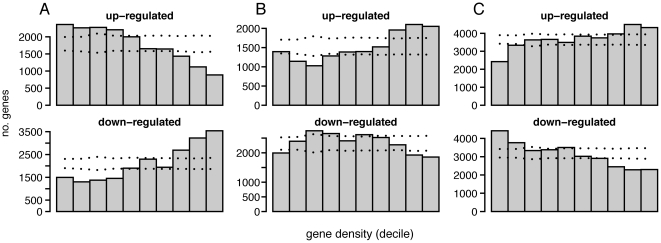
Density-dependent gene expression changes in diseased samples.Barchart showing the number of genes up-regulated (gray bar) or down-regulated (white bar) in diseased tissues compared to control (p<0.05). Genes were divided into 10 groups of equal size, according to the gene density. Dotted lines indicate 95% interval calculated from genome-wide permutation, shuffling regional gene density associated with each gene. (A) Entorhinal cortex [18] (B) Hippocampus [18] (C) Skin lesions and matched normal sample in psoriasis patients [20].